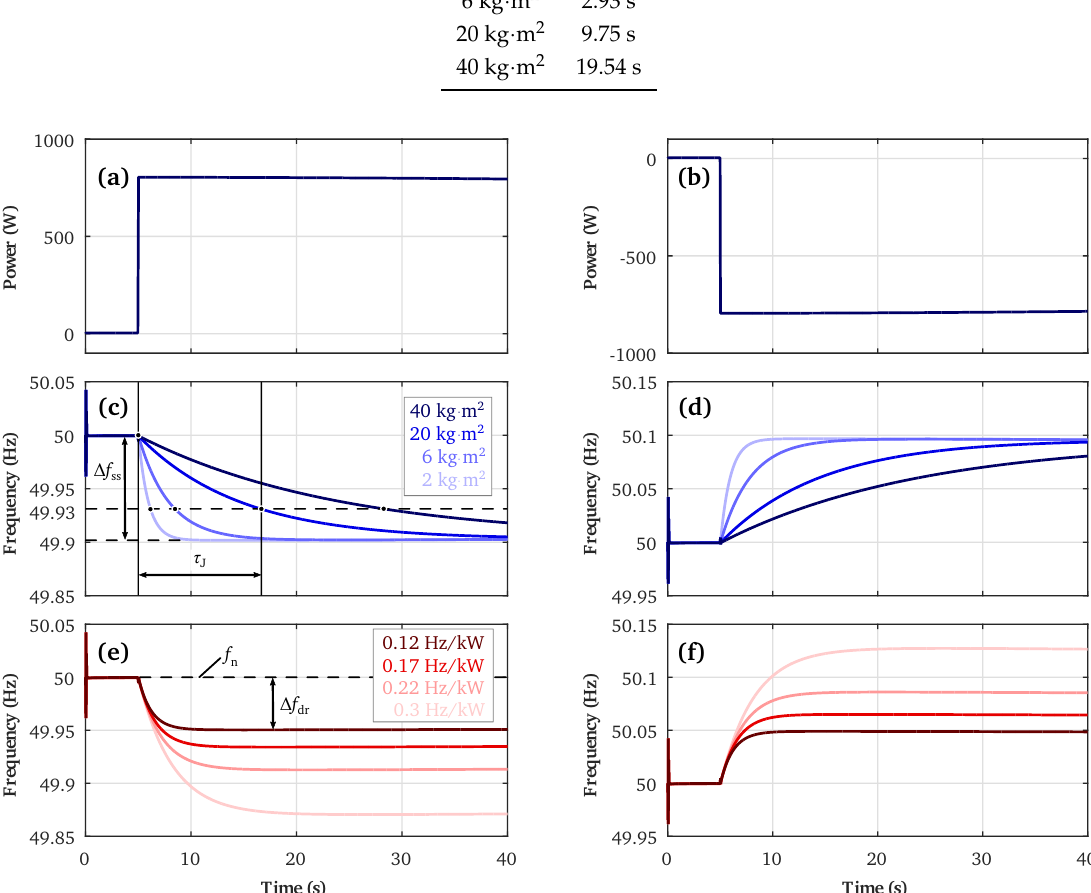
Figure 4. Variation of control parameters in the VSM technique: ( a , b ) Microgrid power variations; ( c , d ) Voltage variations for different values of emulated inertia ( m = 0.25 Hz/kW); and ( e , f ) Voltage variations for different droop slopes ( J = 5 kg · m 2